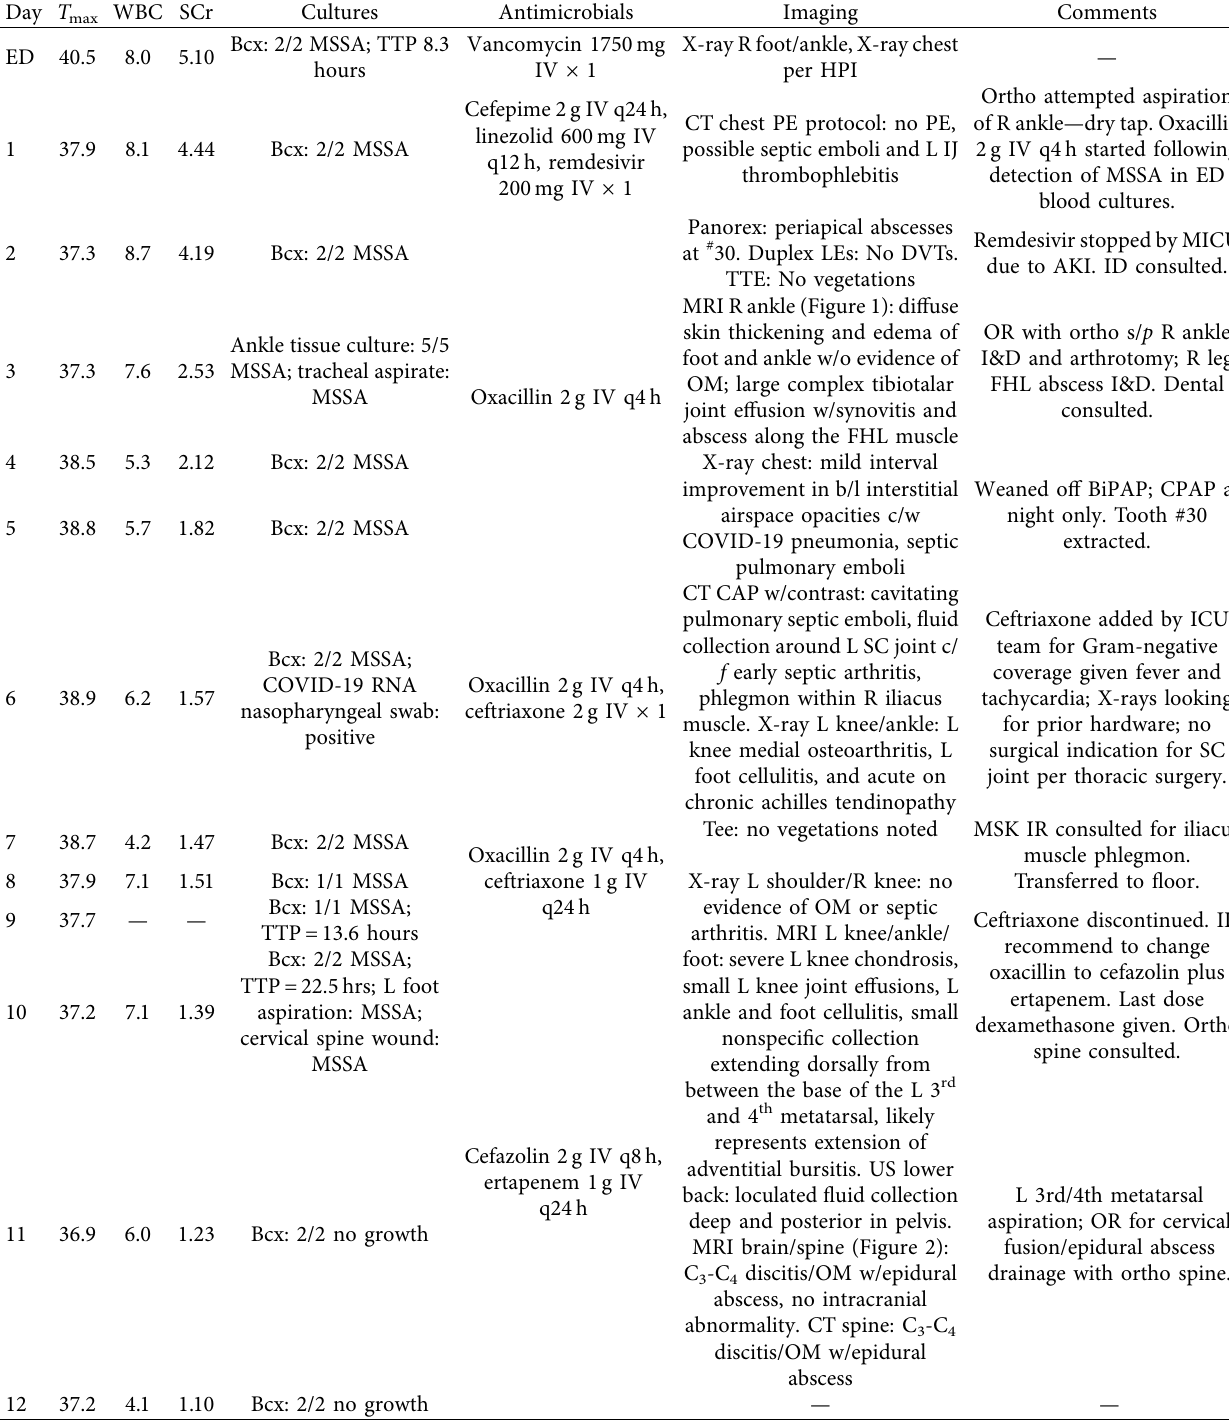
Table 1: Summary of hospital